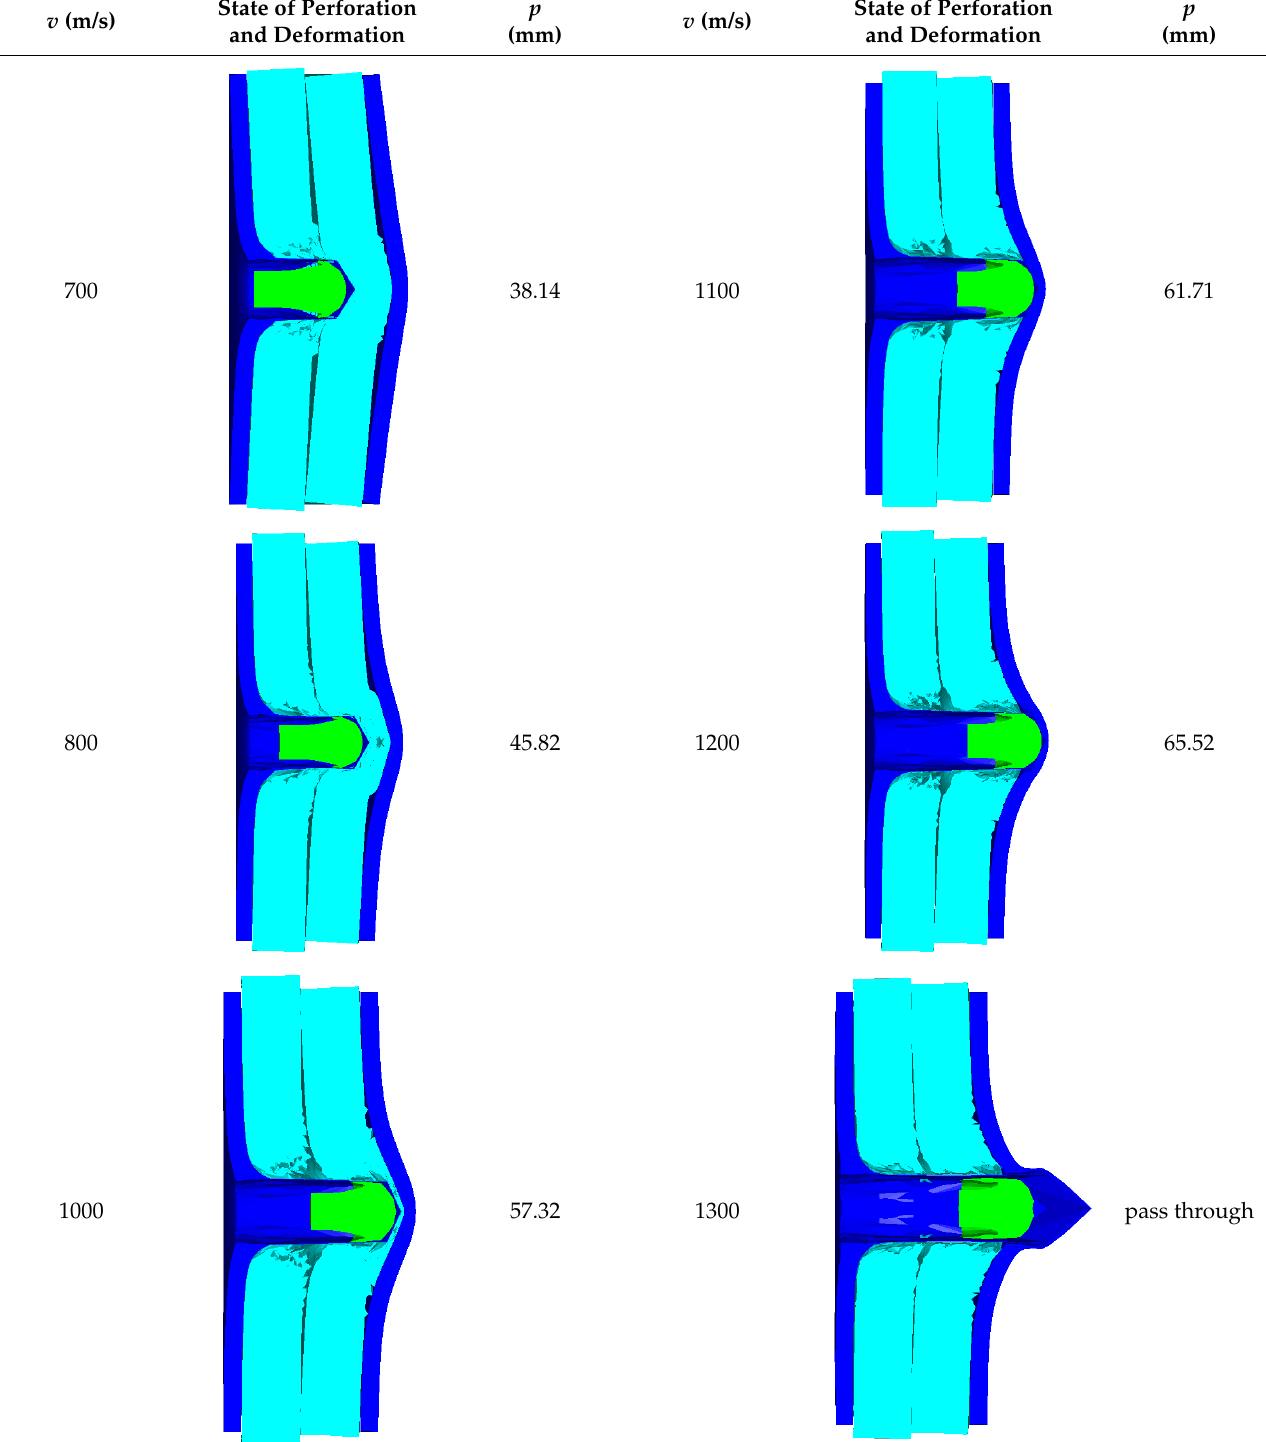
Table 7. Numerical simulation results of projectile penetrating armor with two layers of PE.